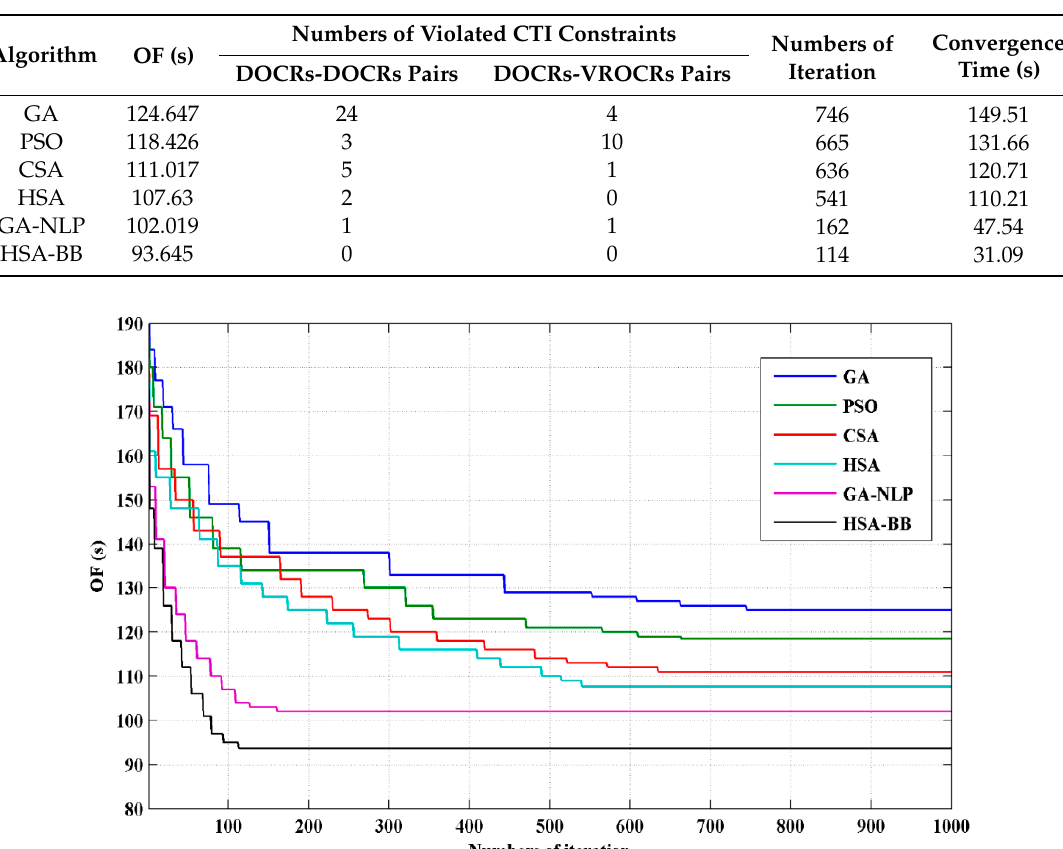
Figure 6. Convergence to the best objective function (OF) value for IEEE 30-bus network.